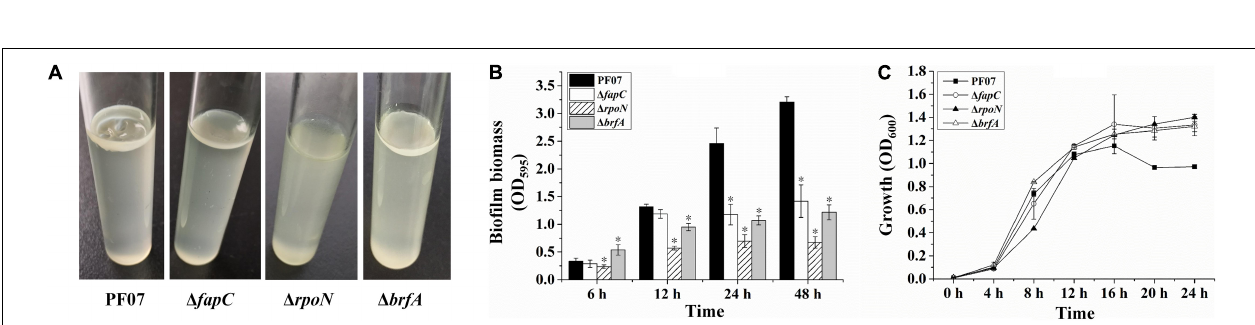
FIGURE 4 | Pellicle and SSA biofilm formation of PF07, (cid:49) fapC , (cid:49) rpoN , and (cid:49) b rfA . (A) Pellicle formed at the air–liquid interface of the standing culture. (B) Crystal violet assay for SSA biofilms in microplates. The biofilm biomass was quantified by crystal violet staining. Data are expressed as mean ± SD of eight replicates. Significant differences between PF07 and the mutants were analyzed by one-way ANOVA, ∗ P < 0.01. (C) The growth curves of PF07 and the mutants in tryptone broth medium with shaking. Data are expressed as mean ± SD of three replicates.